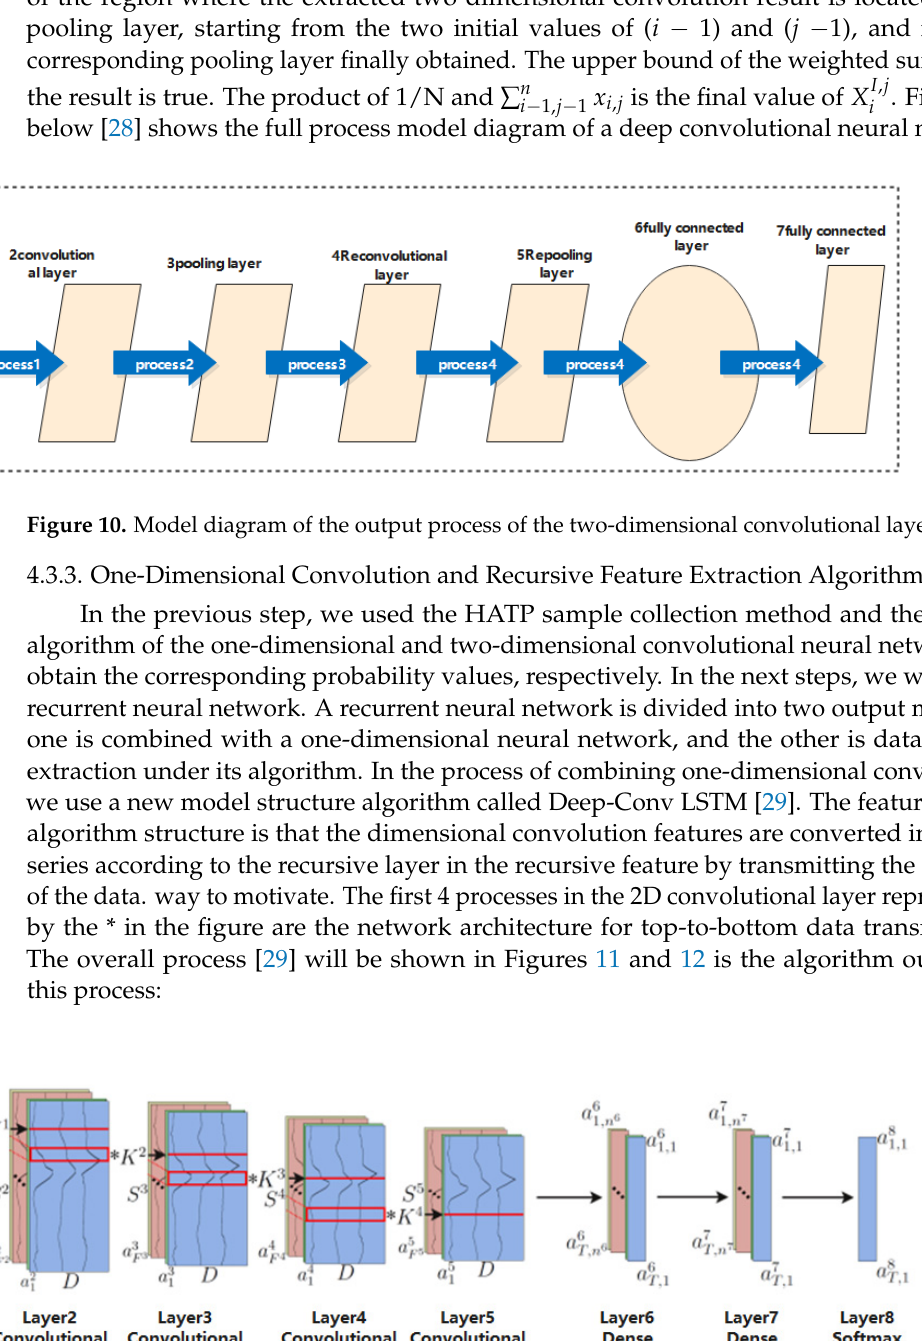
Figure 11. One-dimensional convolution and recursive feature extraction algorithms. From the above figure, we can see that the total dimension and recursive layer are 8 sets of eigenvalues. The features in the model are transmitted in sequence according to the principle of time series [30]. Additionally, there are multiple channels for a single fea- ture in each model. The content in the model diagram is the input data from the sensor from left to right. The first layer in the picture is the input data value of the receiving sensor device, the 2–5 layer is the convolution layer data, and the 6–7 layer is the nonlinear layer. The relationship incentive layer, the last eighth layer, is the classification result of the acquired behavior data [31]. The positioning in the model diagram is that the layer layer represents the data range D × S 1 , where D represents the number of channels of the data, and S I represents the data length of the first layer at this time. Layers 2–5 are convo- lutional layers, K I is the convolution kernel in the first layer, F I is the number of features in the first layer [32], and a, i, I are the feature map excitation of the first layer. The last layer 6, and layer 7 are hidden recursive layers. a, t, I, I represent the excitation data from layer i to layer I at time t in a given time series. S (J+I) = S I − P I +1